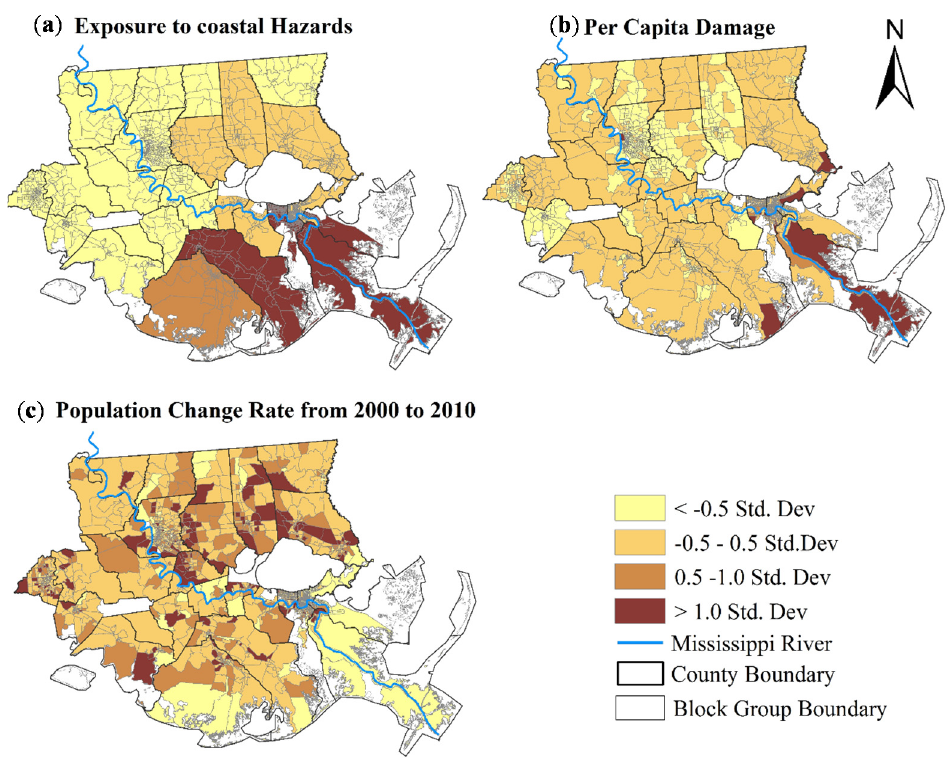
Figure 5. Z-scores of ( a ) exposure to natural hazards; ( b ) Per capita property damage; and ( c ) Population change rate from 2000 to 2010.